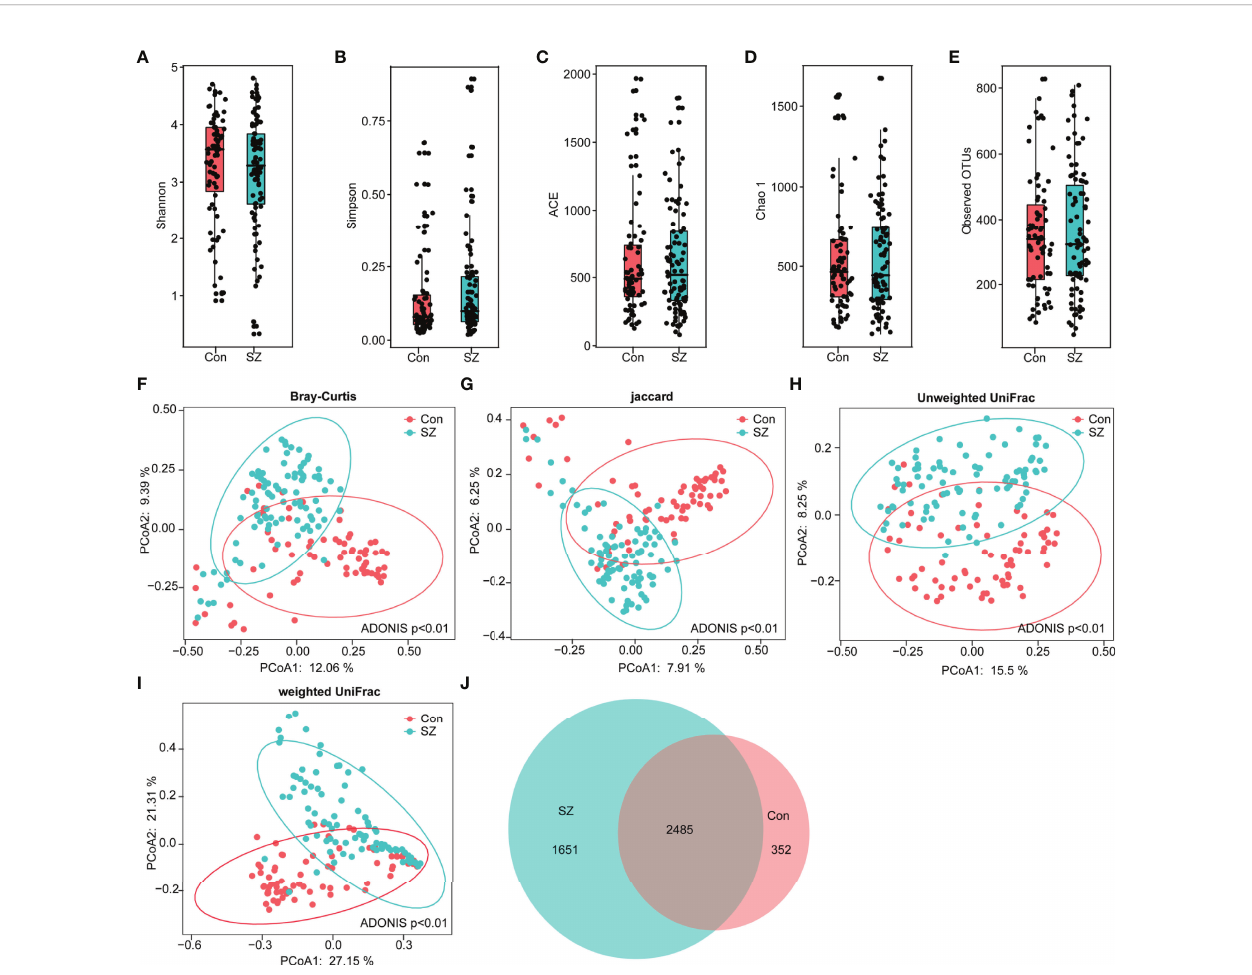
FIGURE 1 | Altered overall structure of the fecal microbiota in elderly SZ patients. The diversity indices of Shannon (A) and Simpson (B) , and the richness indices of ACE (C) , Chao1 (D) , and the observed OTUs (E) were used to evaluate the overall structure of the fecal microbiota in the SZ patients and the healthy controls. The data are presented as mean ± standard deviation. Unpaired t tests (two tailed) were used to analyze the variation between the groups. Principal coordinate analysis (PCoA) plots of individual fecal microbiota based on Bray – Curtis (F) , Jaccard (G) , and unweighted (H) and weighted (I) UniFrac distances in the elderly SZ patients and the healthy controls. Each symbol represents a sample. The Venn diagram illustrates the overlap of OTUs in the SZ-associated microbiota and healthy controls (J)